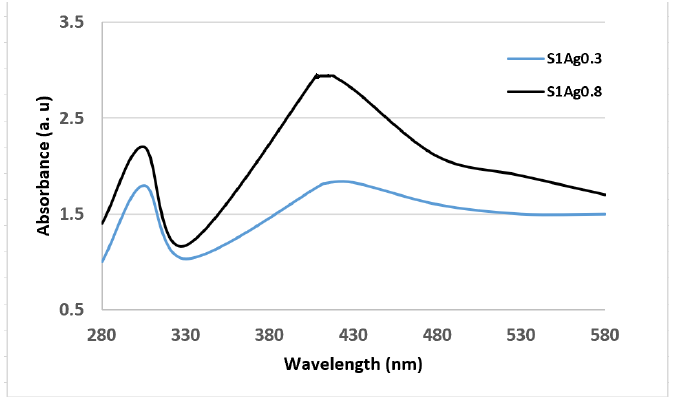
Figure 3. FTIR absorption spectra of S1Ag0.3 and of S1Ag0.8.